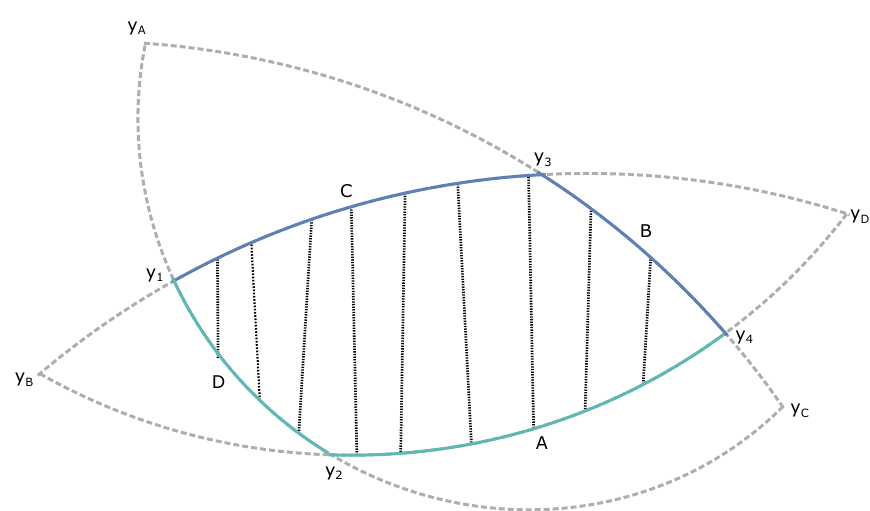
Figure 23 . The 4pt function G (cid:15)(cid:14)(cid:15)(cid:14) of two protected and two unprotected cusps. We assume that 1243 only two scalar polarizations are involved: ~n on the arcs B , C and ~m on the arcs A , D , so that the con(cid:12)guration depends on a single e(cid:11)ective coupling.